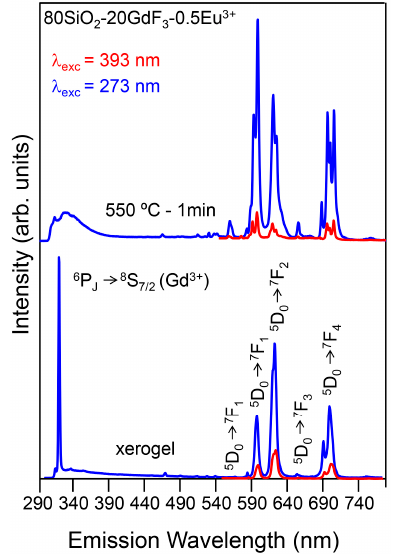
Figure 21. Emission spectra of Eu 3+ and Gd 3+ ions in xerogel ( bottom ) and GC ( top ) treated at 550 °C-1 min under excitation of Eu 3+ at 393 nm (red spectra) and of Gd 3+ at 273 nm (blue spectra).